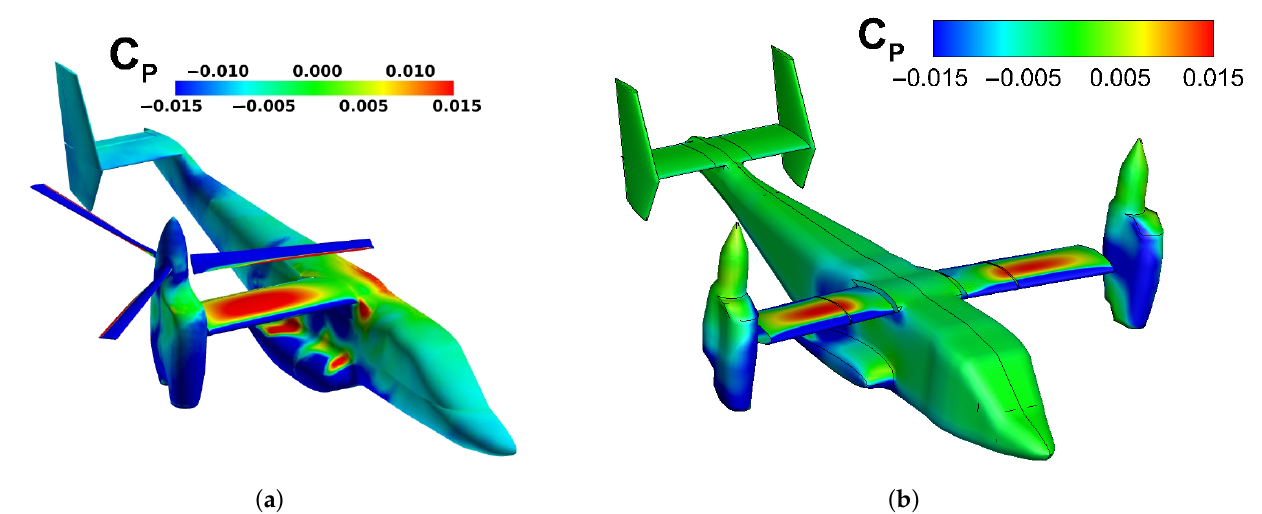
Figure 14. Comparison of the contours of the pressure coefficient C p on the vehicle surface in hover at ψ = 270 ◦ , θ N = 90 ◦ , Ω = 589 RPM. ( a ) Half-span model: CFD [17]; ( b ) Complete model: